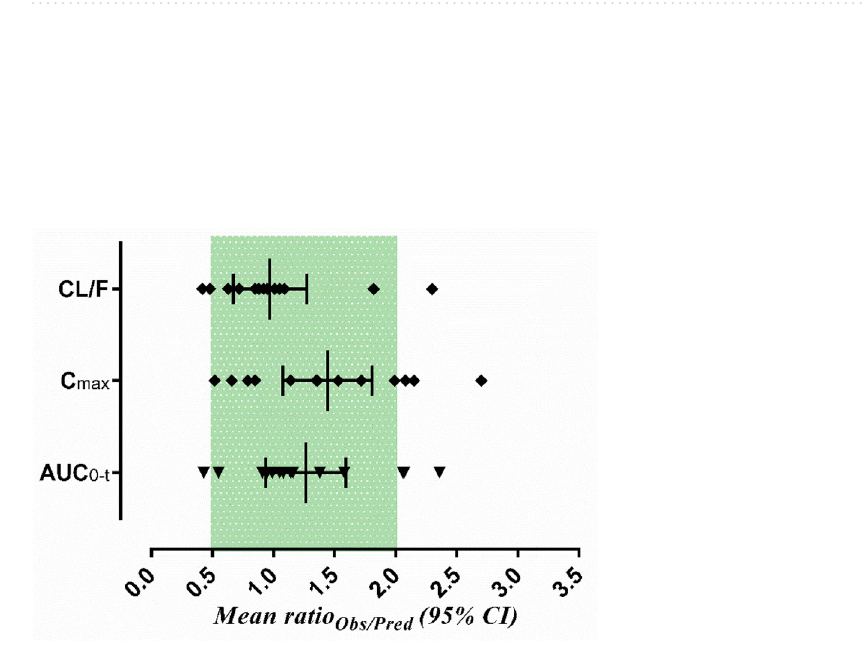
Figure 4. The predicted/observed ratio with their 95% confidence intervals in the 14 pediatrics with renal failure and renal scarring. AUC 0−t ; Area under the concentration–time curve, C max ; Maximum systemic concentration, CL/F; oral